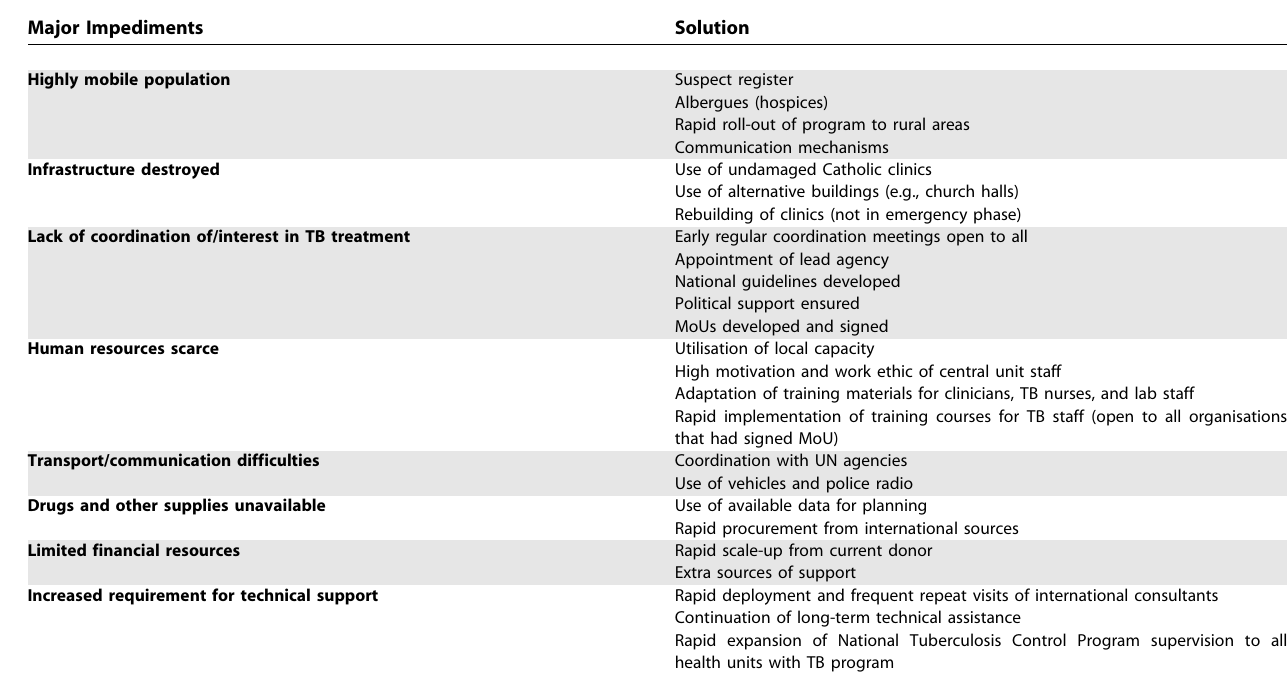
Table 2. The Major Impediments to the Establishment of a National TB Control Program in East Timor, the Solutions Identified, and the Agencies Responsible for Their